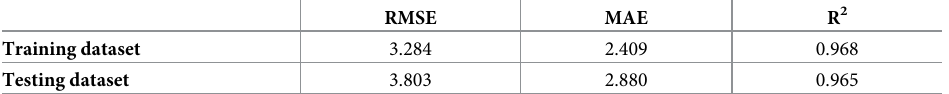
Table 4. Values of the best performance evaluation criteria of ANN-SCG model [8–14–4–1]for training and test- ing dataset.